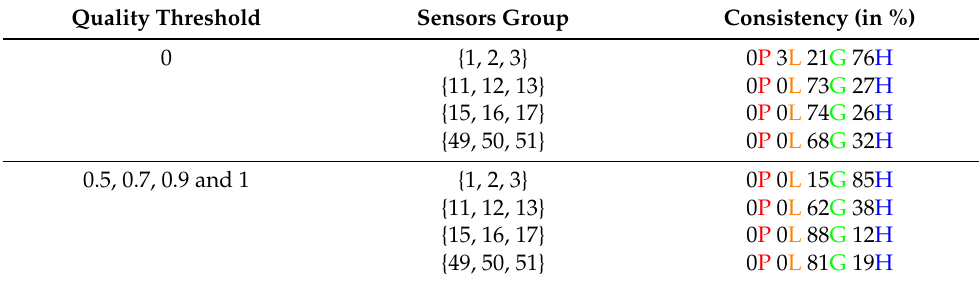
Table 10. Shipments consistency evaluation